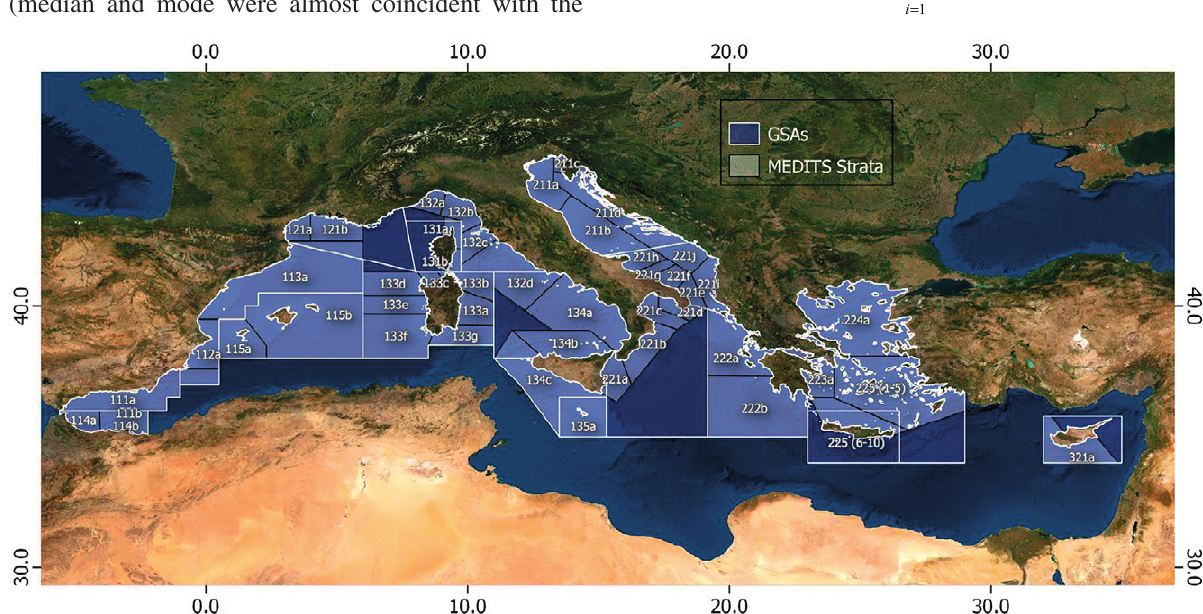
Fig. 3. – Map of the Mediterranean showing the geographic strata (black lines) considered in the MEDITS bottom trawl surveys allocated to the geographical sub-areas (GSAs; white lines) established by the General Fisheries Commission for the